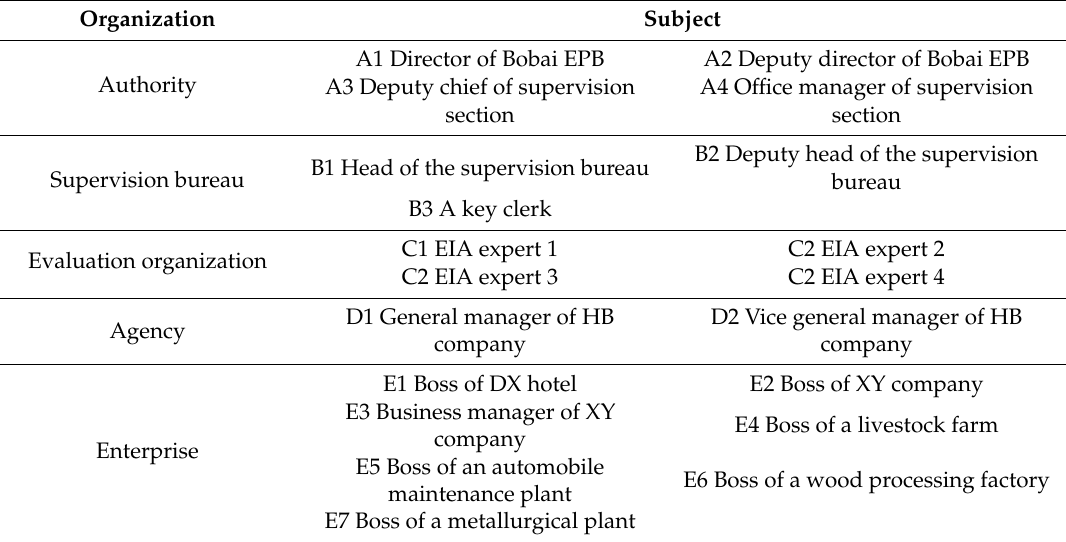
Table 1. The coding List of Environmental Regulatory Capture (ERC) Network